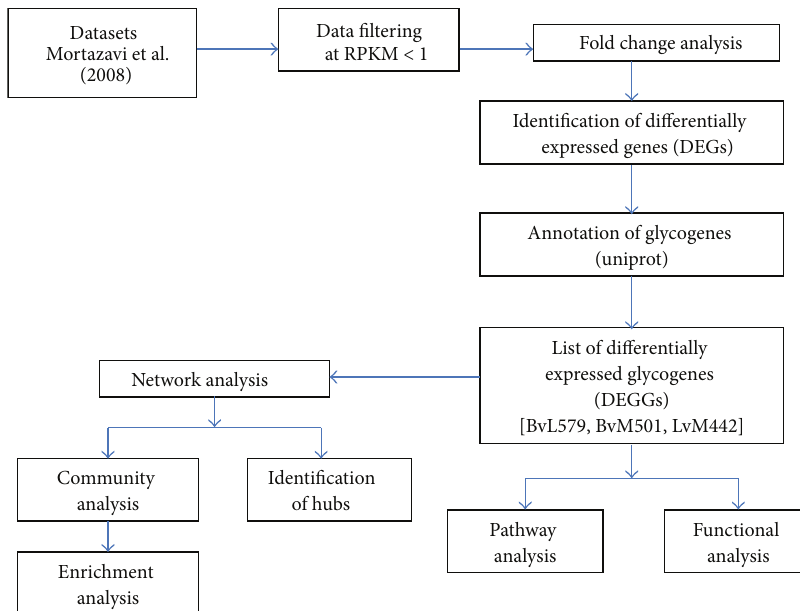
Figure 1: Flowchart depicting the overall methodology adopted in this